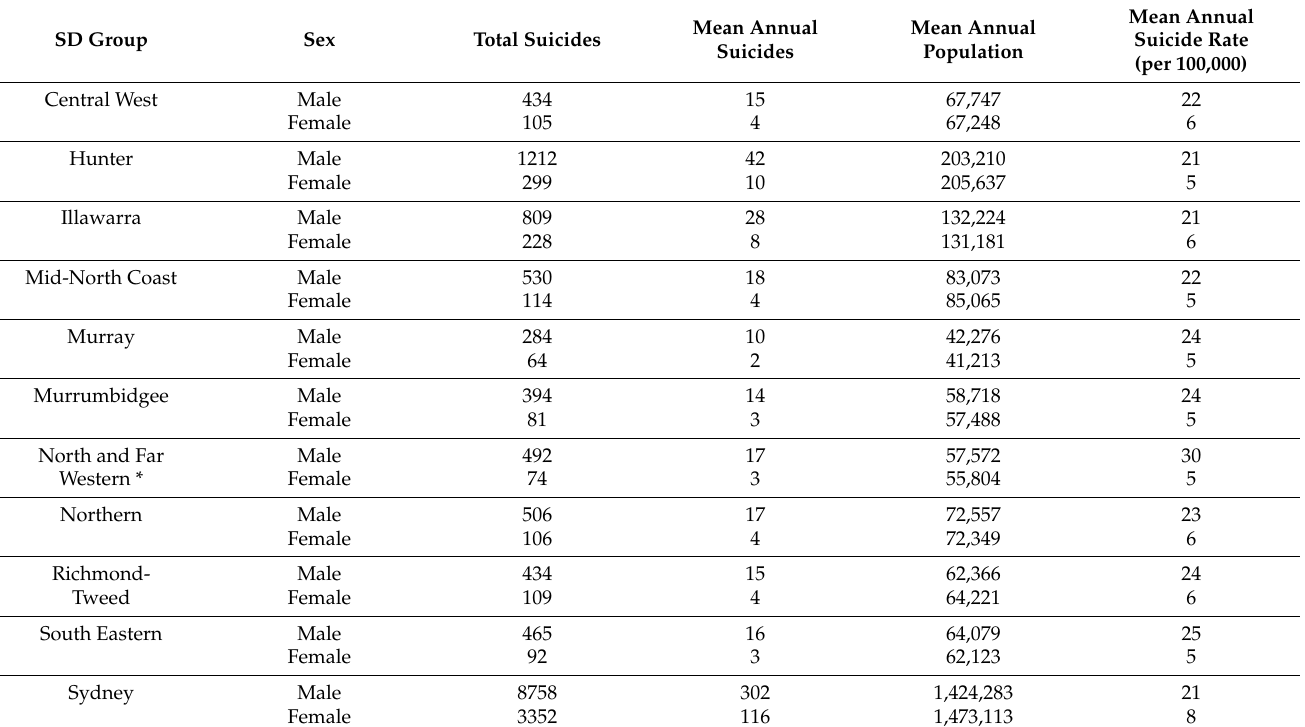
Table 2. Descriptive statistics of suicides and population numbers in NSW SDs during the historical period